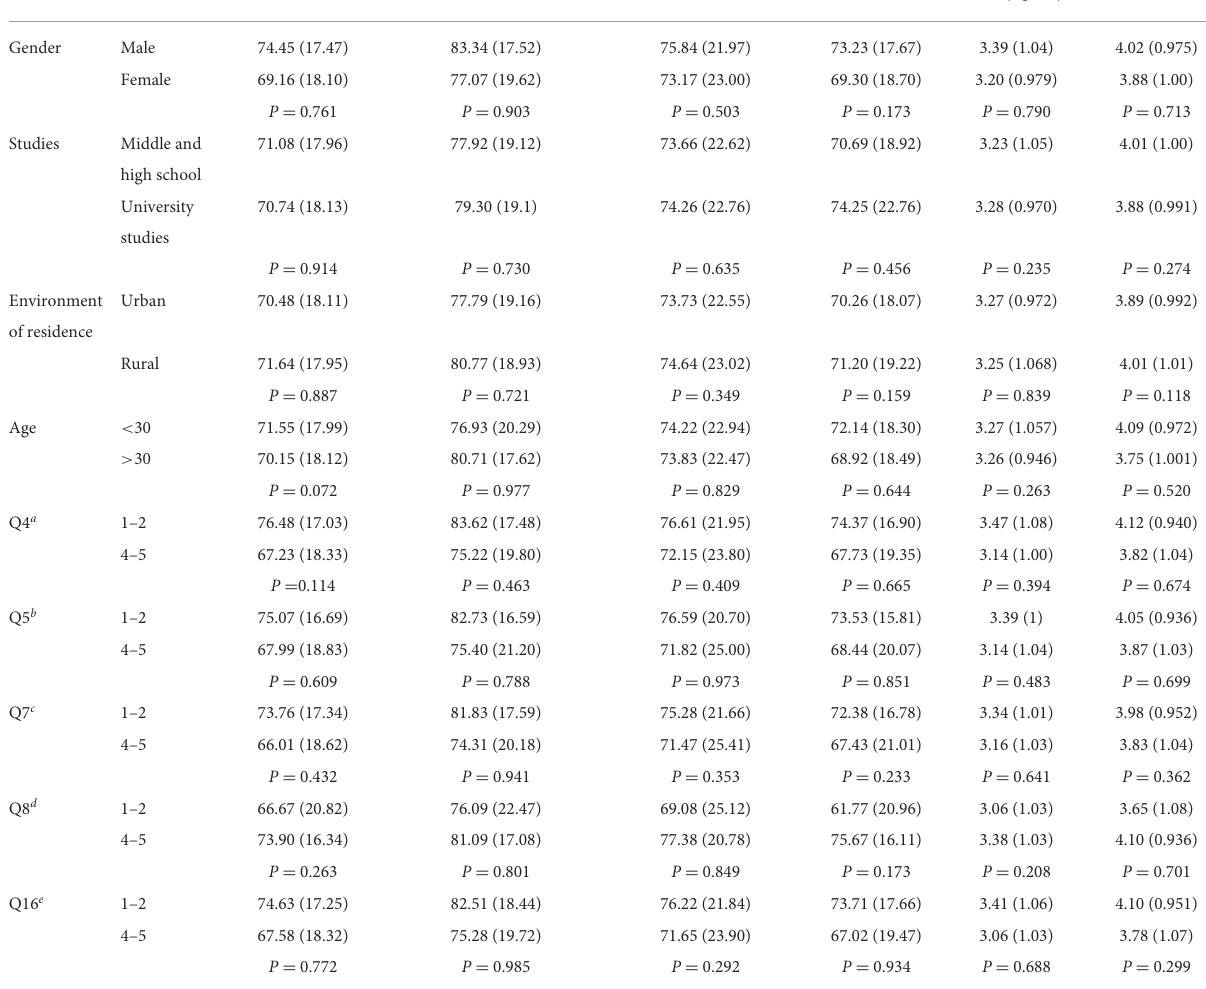
Quality of Health health life (QOL)